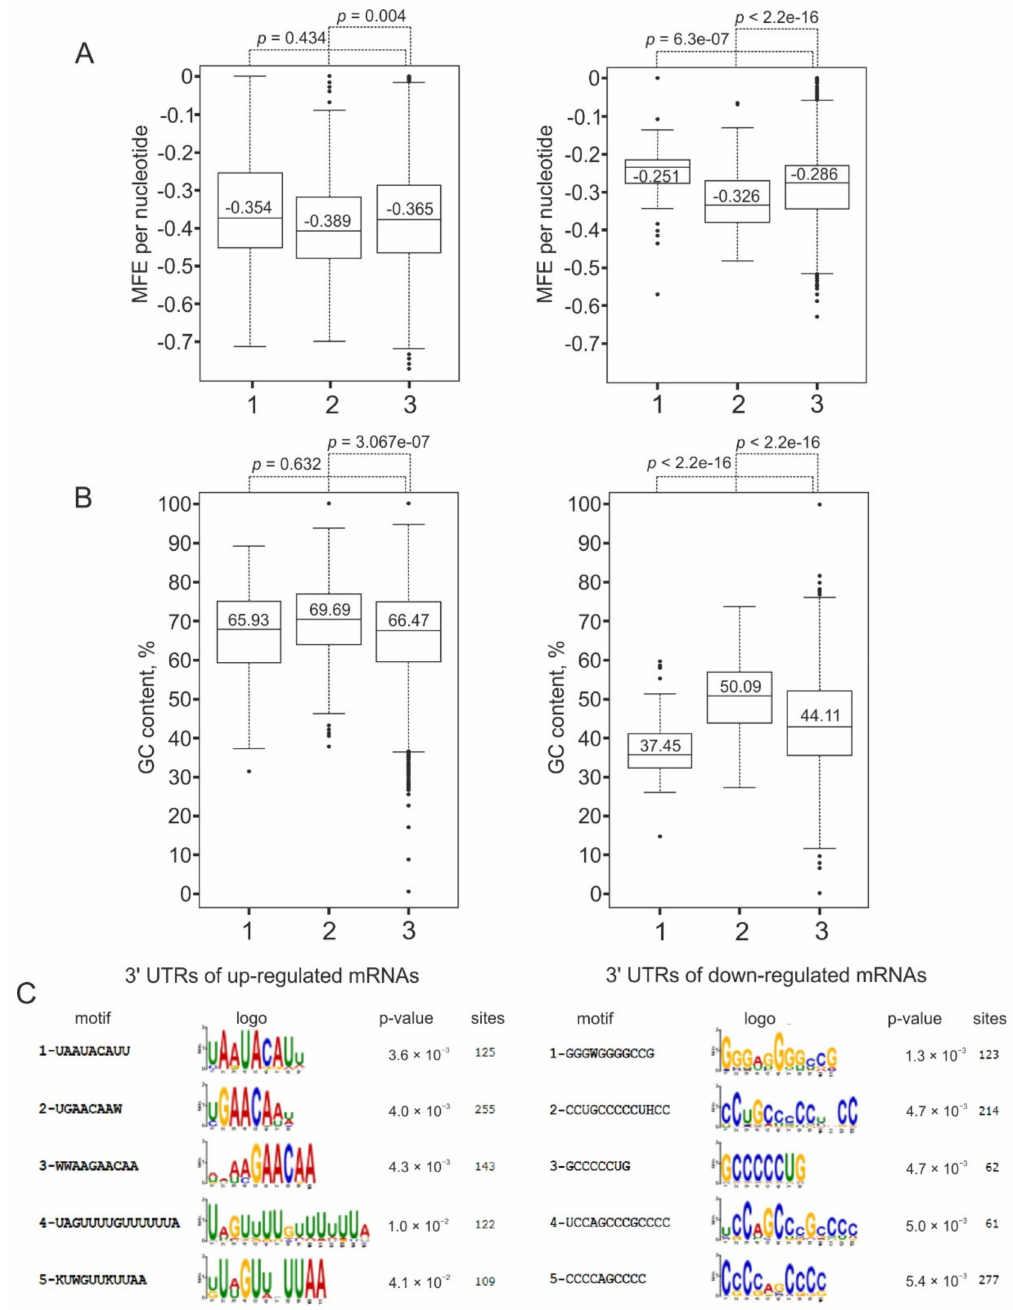
Figure 5. Sequence features of 5 (cid:48) and 3 (cid:48) UTRs of mRNAs of differentially expressed genes at the level of transcription, (t)DEGs, defined for uL5-deficient HEK293T cells. ( A ) Left, the distributions of minimum free energies (MFEs) calculated for 5 (cid:48) UTRs of mRNAs of up-regulated (1) and down-regulated (2) (t)DEGs compared to that of MFEs determined for 5 (cid:48) UTRs of all mRNAs of HEK293T cells (3), shown in the box and whisker diagrams; right, the same for the 3 (cid:48) UTRs. ( B ) Left, GC contents calculated for 5 (cid:48) UTRs of mRNAs of up-regulated (1) and down-regulated (2) (t)DEGs compared to those determined for 5 (cid:48) UTRs of all mRNAs of HEK293T cells (3); right, the same for the 3 (cid:48) UTRs of mRNAs. ( C ) Top 5 from the set of motifs (with lowest p values) identified in 3 (cid:48) UTRs of mRNAs of up-regulated (left) and down-regulated (right) (t)DEGs. Column “sites” means a number of sites for the respective